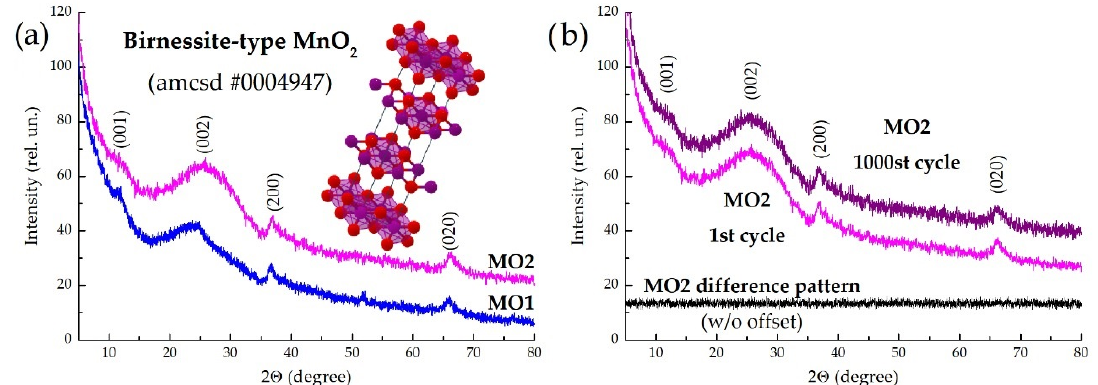
Figure 3. XRD patterns of MO1 and MO2 ( a ), XRD patterns of MO2 before (1st cycle) and after (1000st cycle) cycling charge–discharge testing ( b ). cycle) cycling charge–discharge testing ( b ).